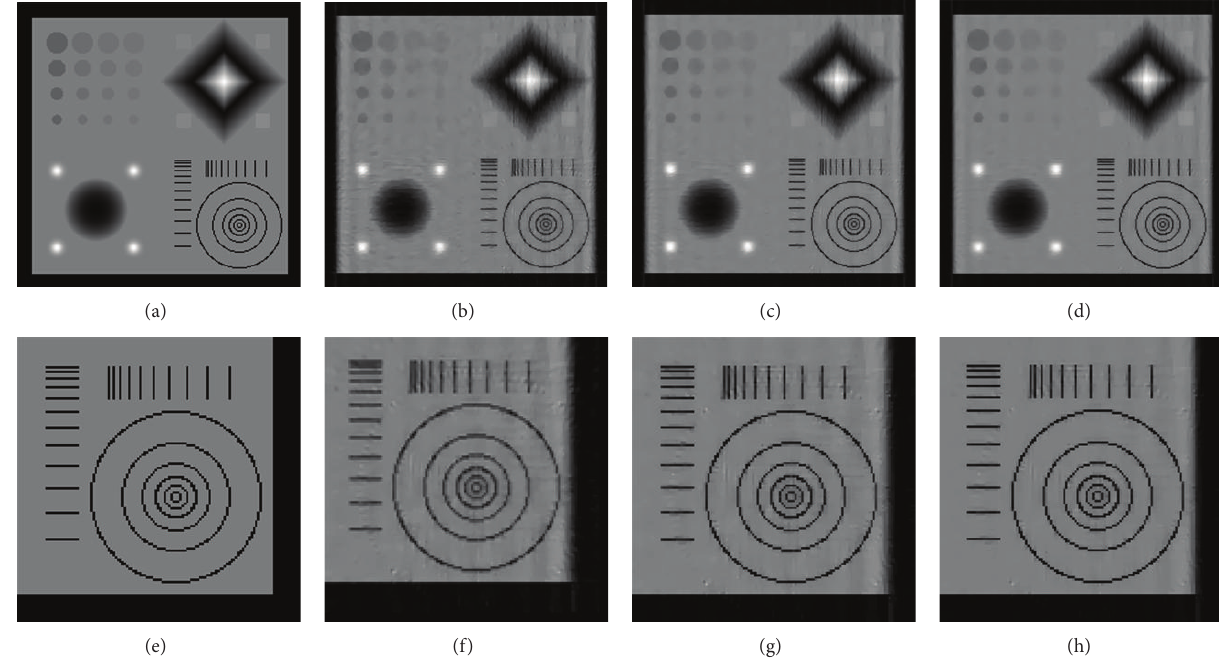
Figure 8: Original phantom image and experimental results. (a) Original phantom image. Reconstruction at sampling rate 0.2 by (b) CS; (c) CS DT-CWT; (d) iCS technique; (e), (f), (g), and (h) are detail views of region outlined by arrow in (a), (b), (c), and (d), respectively. Gray level is normalized in [0, 1]